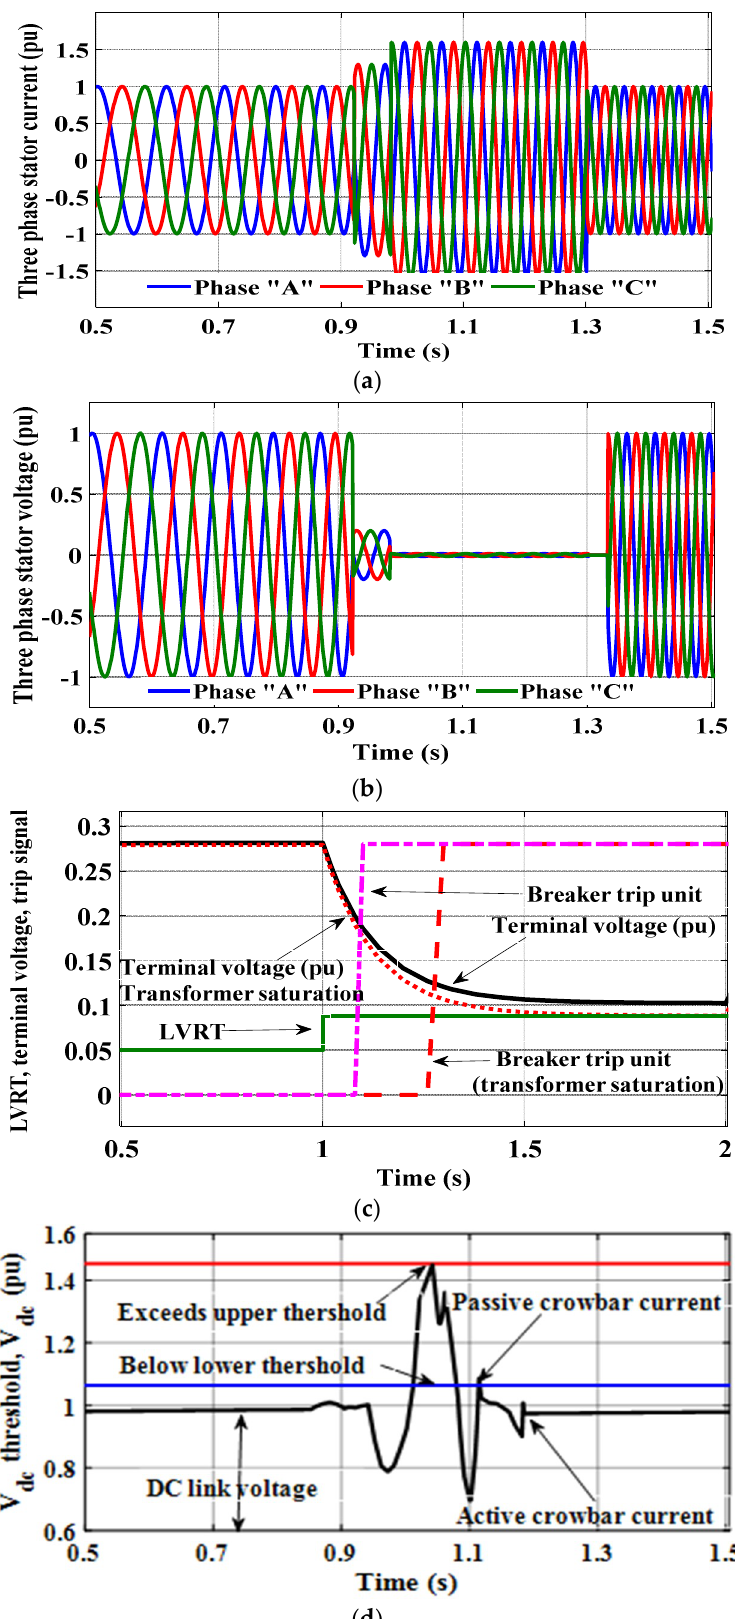
Figure 5. ( a ) Stator current during three-phase fault; ( b ) stator voltage during three-phase fault; ( c ) transformer saturation effect on the terminal voltage during a fault; ( d ) DC link voltage response during fault conditions.